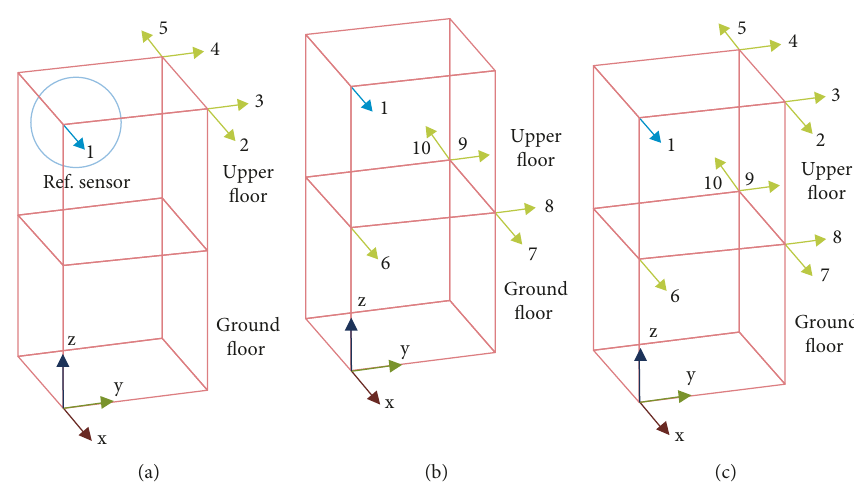
Figure 8: Sensor placements of two-story houses. (a) 1 st test. (b) 2 nd test. (c) All tests.